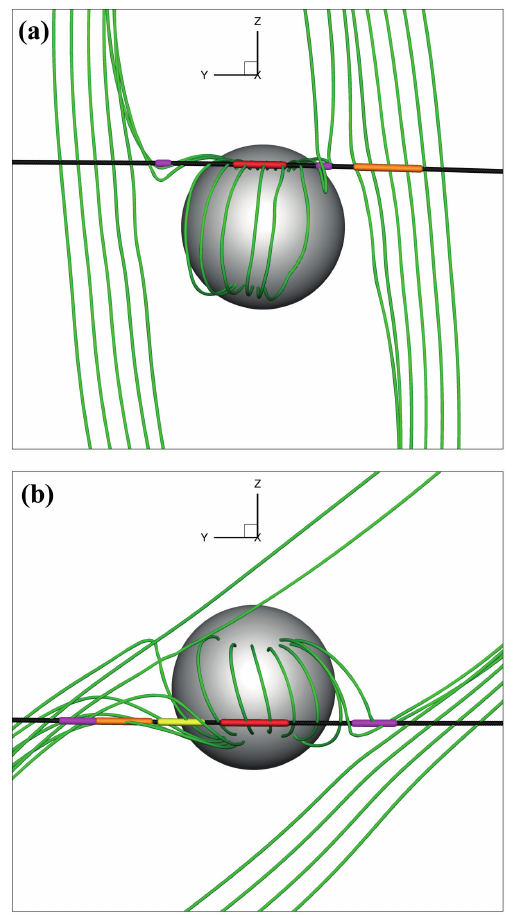
Fig. 12. A overview of the location of the various ULF wave modes along the two flybys: (a) G8 and (b) G28. The field line resonances are in red, the O + cyclotron waves in orange, the O + waves in yellow and the magnetopause waves in purple. Magnetic field lines are traced along the orbits and shown in green, which are obtained from the numerical model of Jia et al.